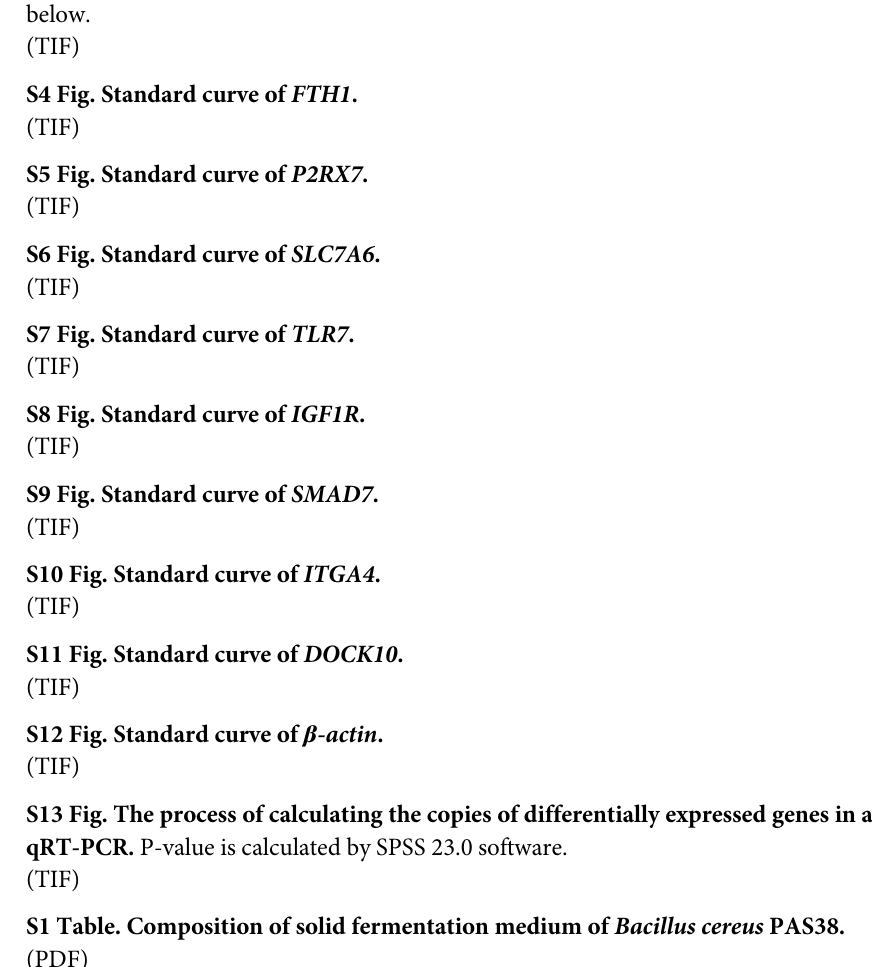
S3 Fig. Standard curve of JCHAIN . The abscissa represents the concentration of plasmid stan- dard (Log N copies/ μ L). The longitudinal coordinates denote the cycle threshold. The same 10 below. S4 Fig. Standard curve of FTH1 . S5 Fig. Standard curve of P2RX7 . S6 Fig. Standard curve of SLC7A6 . S7 Fig. Standard curve of TLR7 . S8 Fig. Standard curve of IGF1R . S9 Fig. Standard curve of SMAD7 . S10 Fig. Standard curve of ITGA4 . S11 Fig. Standard curve of DOCK10 . S12 Fig. Standard curve of β -actin . S13 Fig. The process of calculating the copies of differentially expressed genes in absolute qRT-PCR. P-value is calculated by SPSS 23.0 software. S1 Table. Composition of solid fermentation medium of Bacillus cereus PAS38. (PDF) S2 Table. Alignment results of sequencing clones on